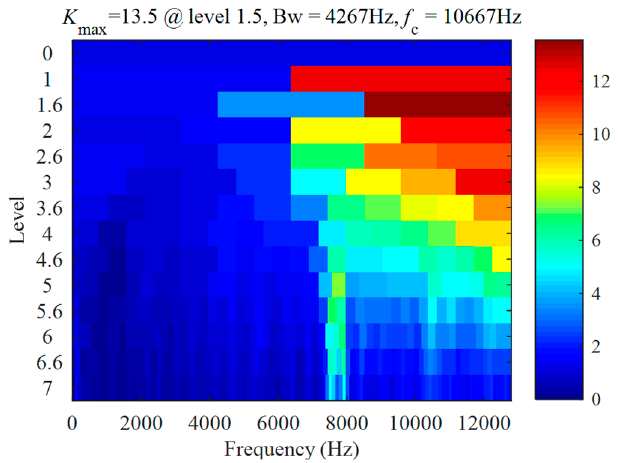
Figure 7. Case 1 for outer race defect: Kurtogram results of the vibration signal.